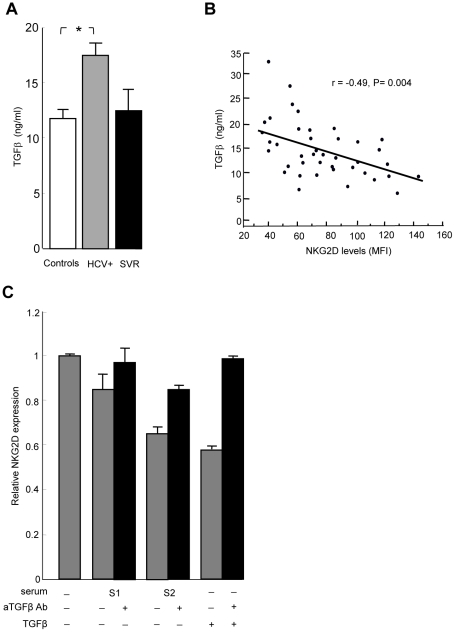
TGFβ is overproduced in HCV patients, and mediates NKG2D reduction on NK cells.A) The levels of total TGFβ were significantly higher in serum from 34 HCV patients compared to 23 controls (* P = 0.008). Only 4 samples from SVR patients could be analyzed. B) Inverse correlation between serum TGFβ levels and NKG2D levels on NK cells in HCV patients. Pearson's correlation coefficient r = −0.49, P = 0.004. C) NKG2D levels are reduced in a TGFβ-dependent manner. NK cells were cultured in medium alone, or in medium containing 10% serum from representative HCV patients with known TGFβ concentration (S1: 6 ng/ml, i.e. 0.6 ng/ml final concentration; S2: 32 ng/ml, i.e. 3.2 ng/ml final concentration), or in medium containing 10 ng/ml of recombinant TGFβ. NKG2D expression was analyzed 24 hr later by flow cytometry. Addition of 10 µg/ml of neutralizing anti-TGFβ mAb during incubation largely reversed NKG2D reduction. Results are expressed as NKG2D levels on NK cells cultured in each indicated condition relative to the levels on NK cells cultured in medium alone, and represent mean ± SEM of 2 independent experiments. P = 0.02 for all comparisons (Kruskall Wallis test).